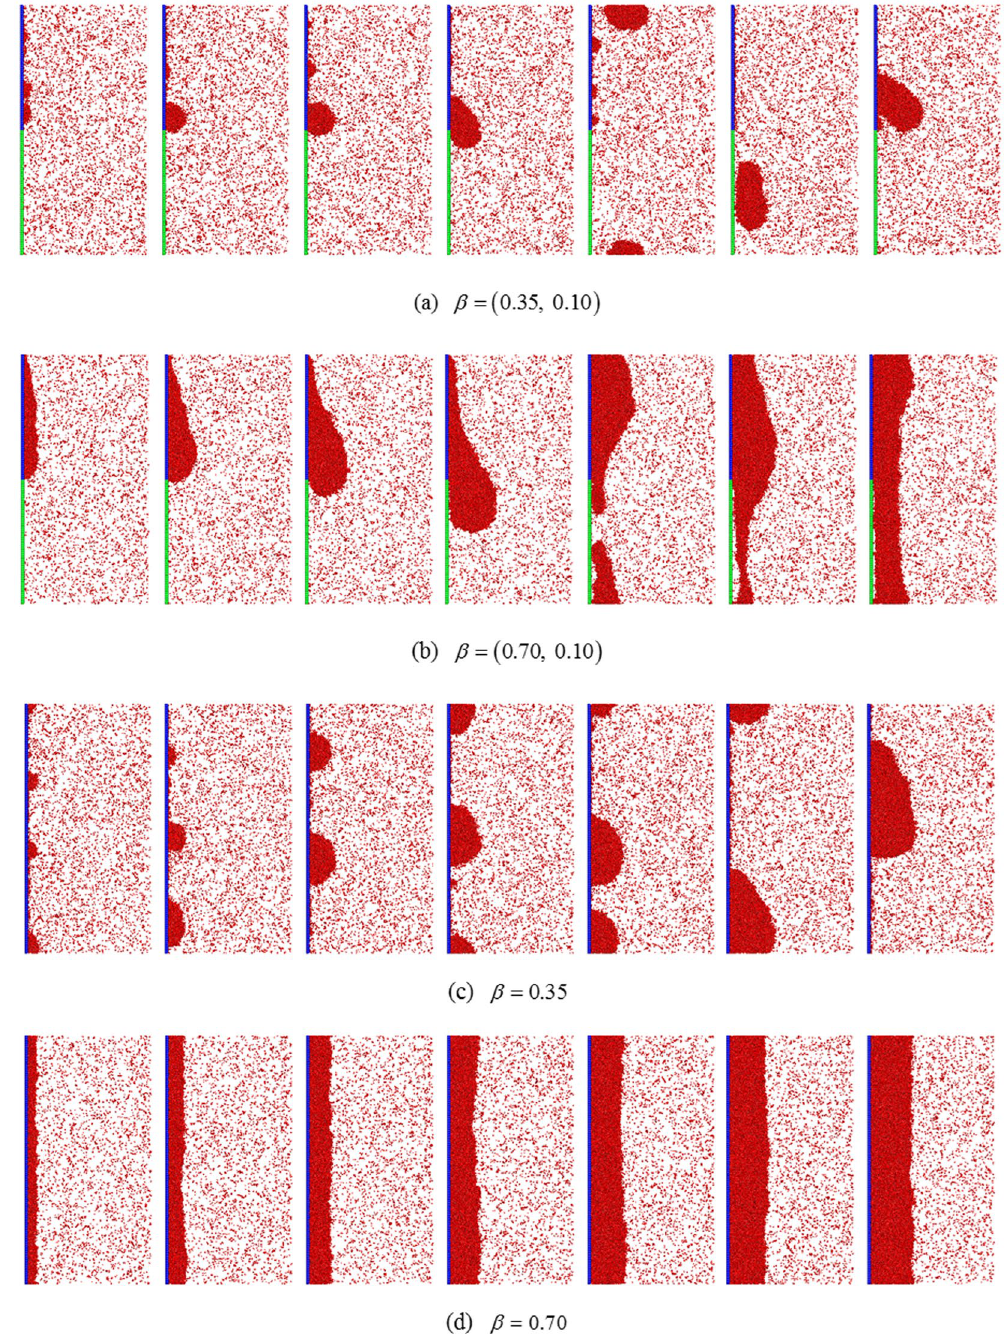
Figure 2. Snapshots at t = 1000 τ , 2000 τ , 3000 τ , 4000 τ , 5000 τ , 6000 τ and 7000 τ (left to right) in the condensation